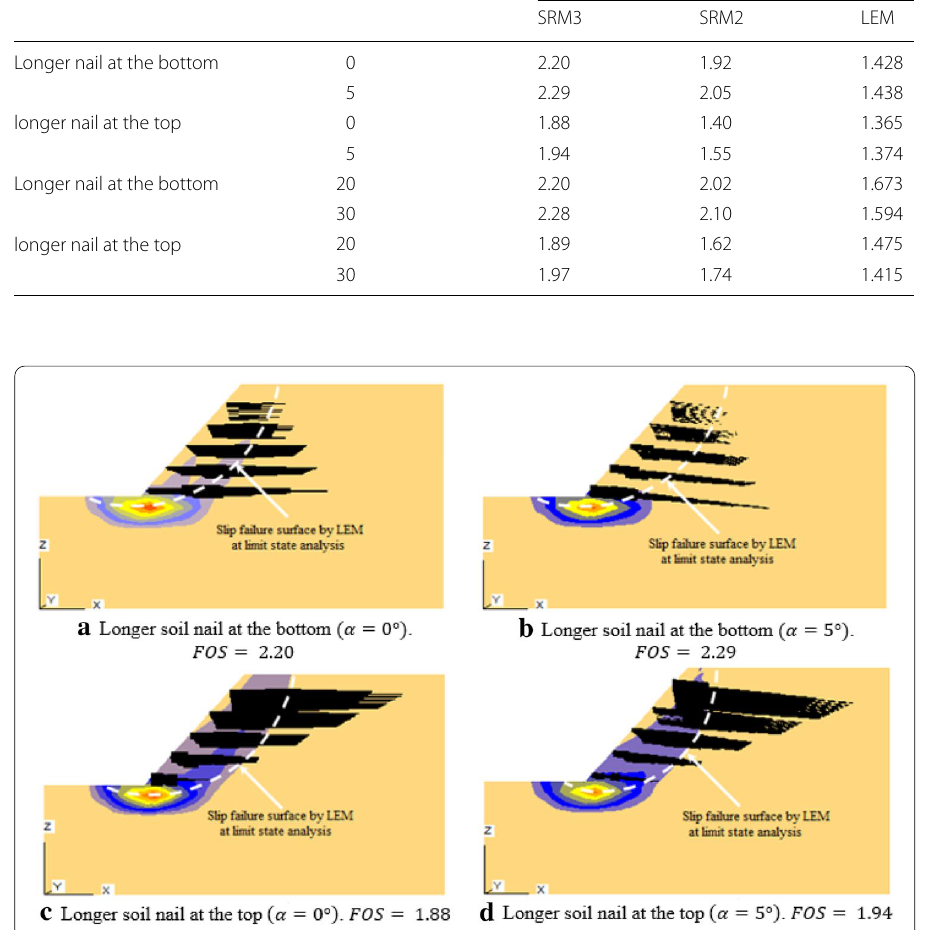
Fig. 13 Response of the 3D model under different soil nail